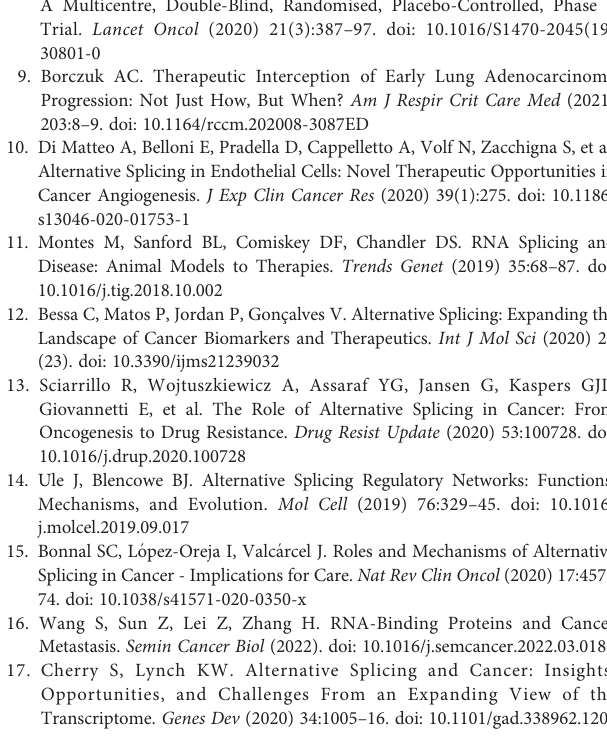
Supplementary Figure 1 | Correlations between prognostic model and immune cell in fi ltrations across LUAD, including (A) B cells naïve, (B) dendritic cells resting, (C) mast cells resting, (D) monocytes, (E) T cells CD4 memory resting, (F) macrophage M0, (G) macrophage M1, (H) NK cells resting, (I) T cells CD4 memory activated, (J) T cells follicular helper, and (K)